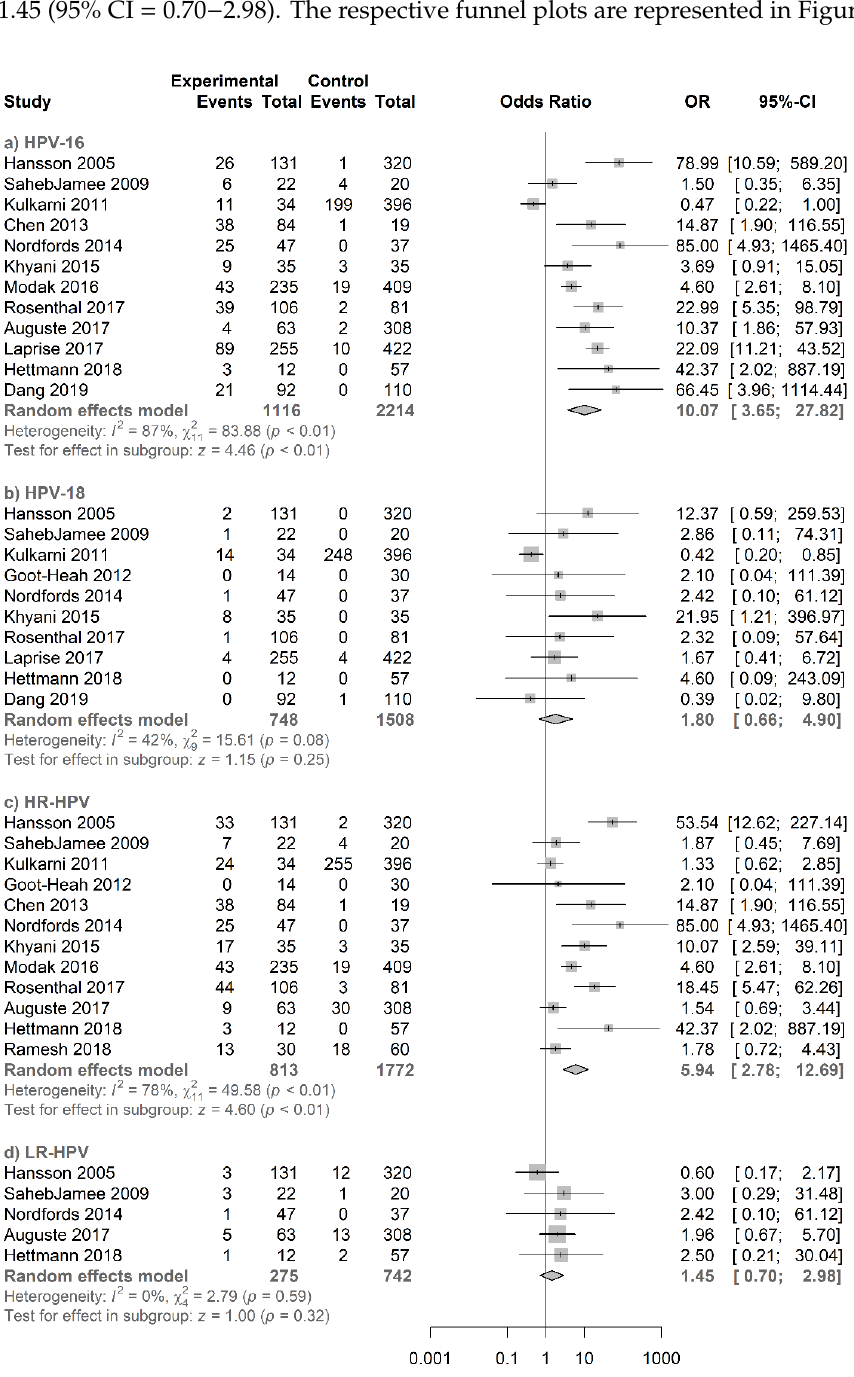
Figure 5. Forest plot for the studies on the association between salivary HPV and oral and oropharyngeal cancer. The squares indicate the ORs in each study, with square sizes inversely proportional to the standard error of the OR. The diamond shape indicates the pooled ORs. Horizontal lines represent 95% CIs. I2 > 50% indicates severe heterogeneity. ( a ) HPV16, ( b ) HPV18, ( c ) HR-HPV, and ( d )